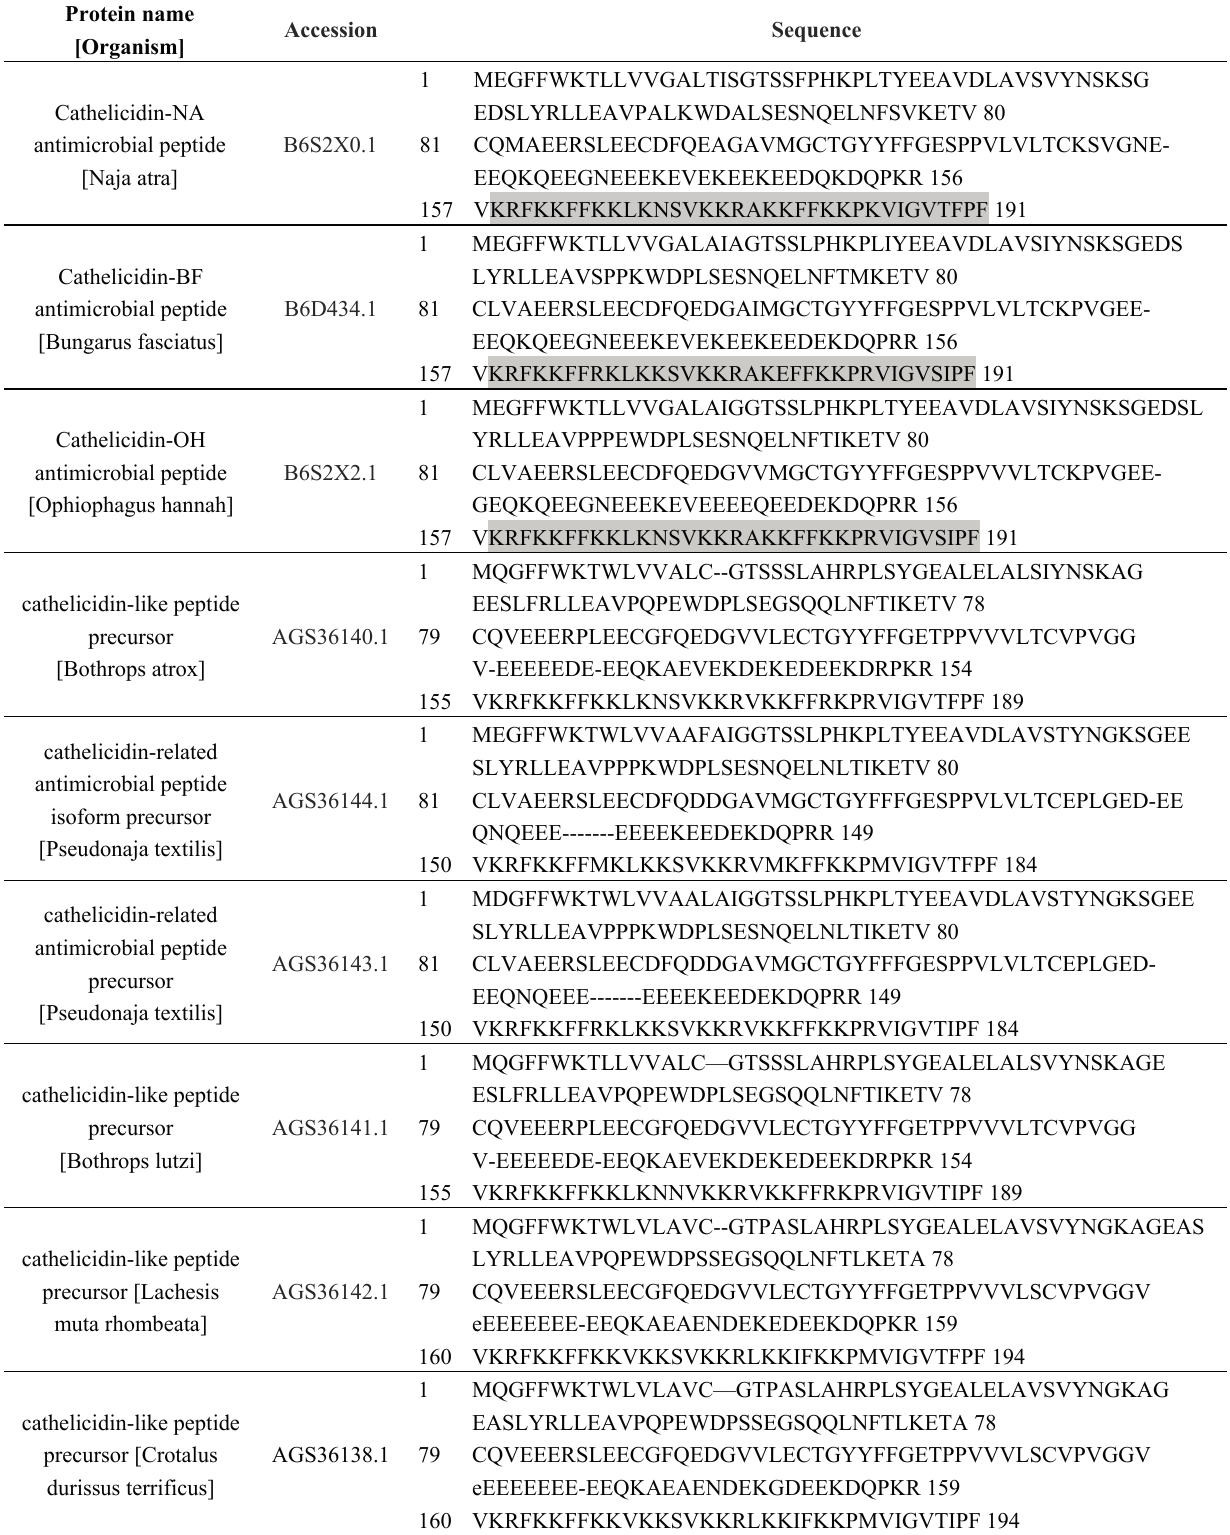
Table 3. Known and predicted cathelicidin open reading frames in multiple snake species. The active antimicrobial peptides NA-CATH, BF-CATH and OH-CATH are